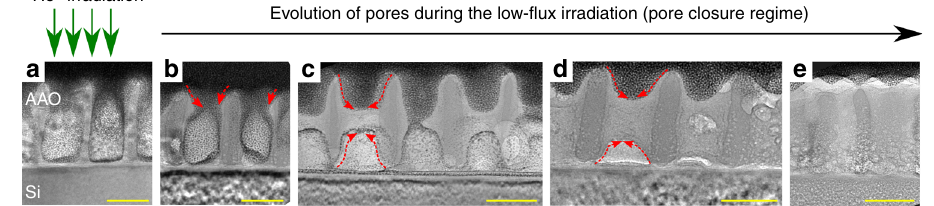
Fig. 3 Evolution of pores during the closure. TEM images show FIB-prepared cross-sections at different fl uence stages of pore closure, after low- fl ux irradiation of am-AAO sample on Si substrate with 25 keV He + . Irradiation fl uence from ( a - e ): 0, ~5 × 10 14 , ~2 × 10 15 , ~3 × 10 15 , and ~2 × 10 16 ions cm − 2 . The red arrows follow the mass- fl ow pattern. The scale bar is 50 nm